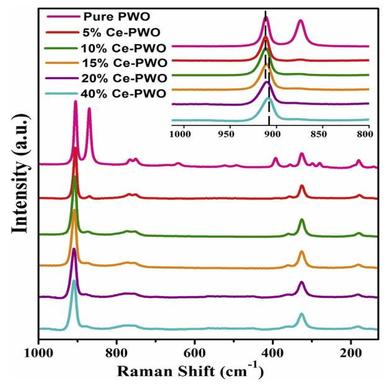
Raman spectra of the PbWO4 doped with Ce at different molar fractions.